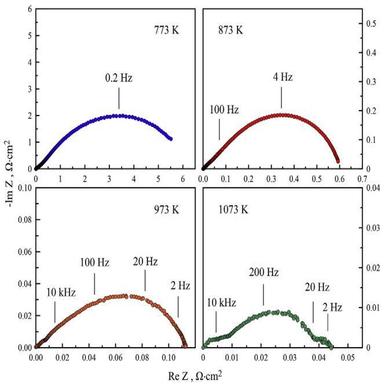
The experimental spectra of full impedance for the symmetrical cell with composite PYBCN/SDC ¼ 70/30 wt% electrodes at different temperatures in the air.